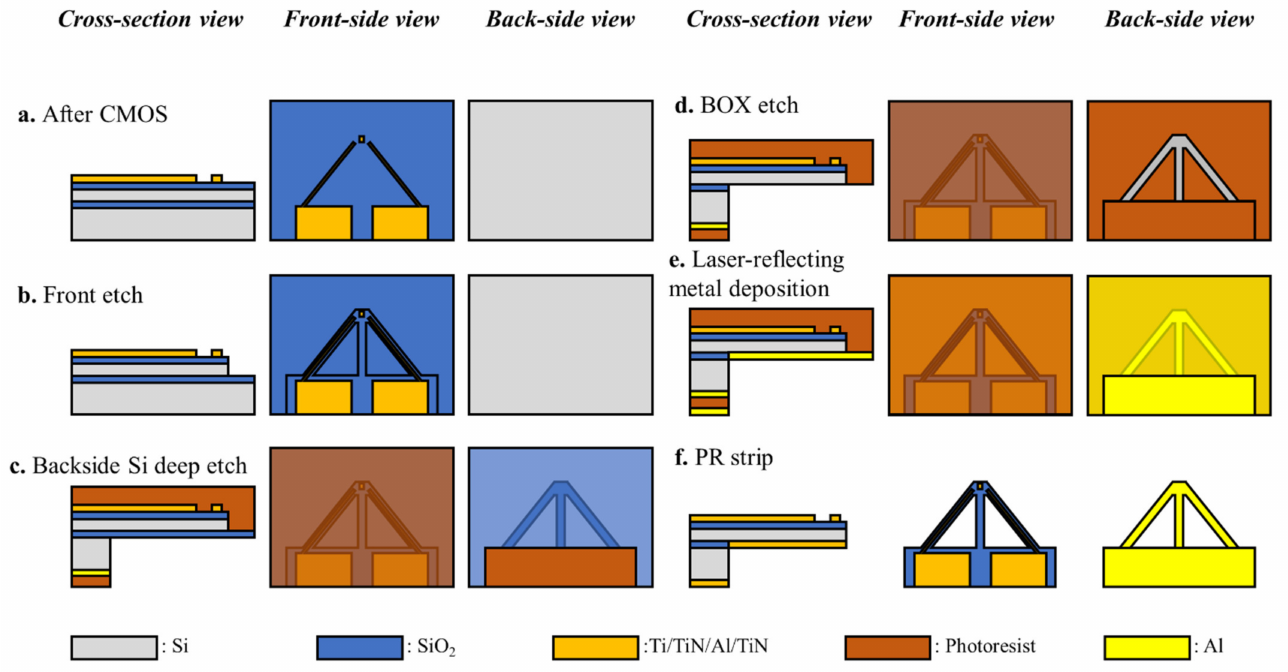
Figure 3. Fabrication of the V-shaped cantilever: ( a ) ILD and electrodes were exposed after the CMOS process. ( b ) Front-side was etched to the cantilever shape via the reactive ion etching (RIE) process. ( c ) Si deep etch via deep reactive ion etching (DRIE) process was performed from the backside of the wafer. ( d ) Buried oxide was etched via wet etching using the buffered oxide etchant (BOE). ( e ) Reflecting metal (Al) was deposited onto the backside of the cantilever. ( f ) Photoresists were stripped using